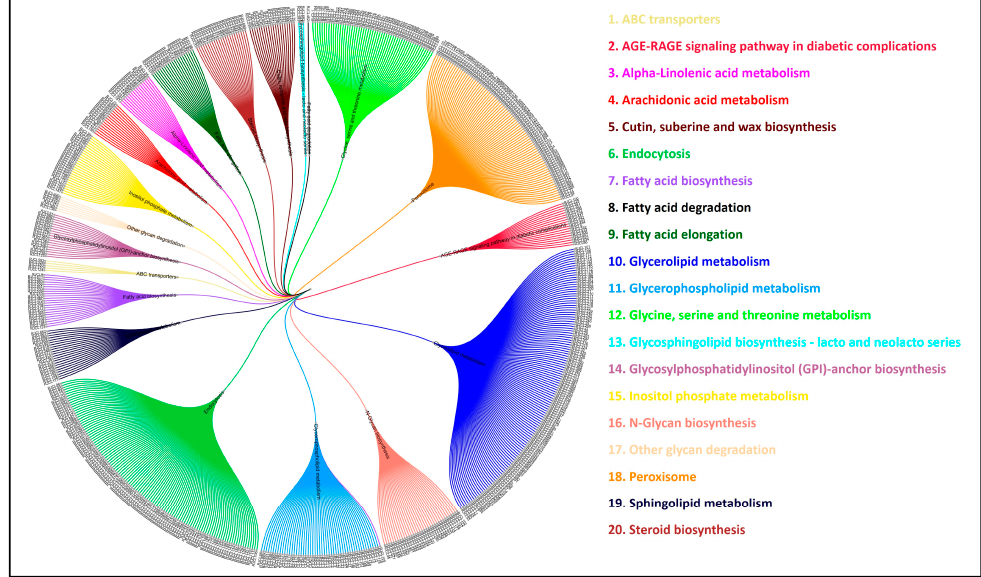
Figure 4. The 20 lipid metabolizing pathways and their components (as labelled 1–20), with the outer circle representing the individual RJCL genes that are involved in respective activities. In total, 693 lipid-metabolizing genes of RJC1 (RJCL: Jatropha Cultivar1 Lipid; RJCL1-RJCL693) are shown in outer-most circle.